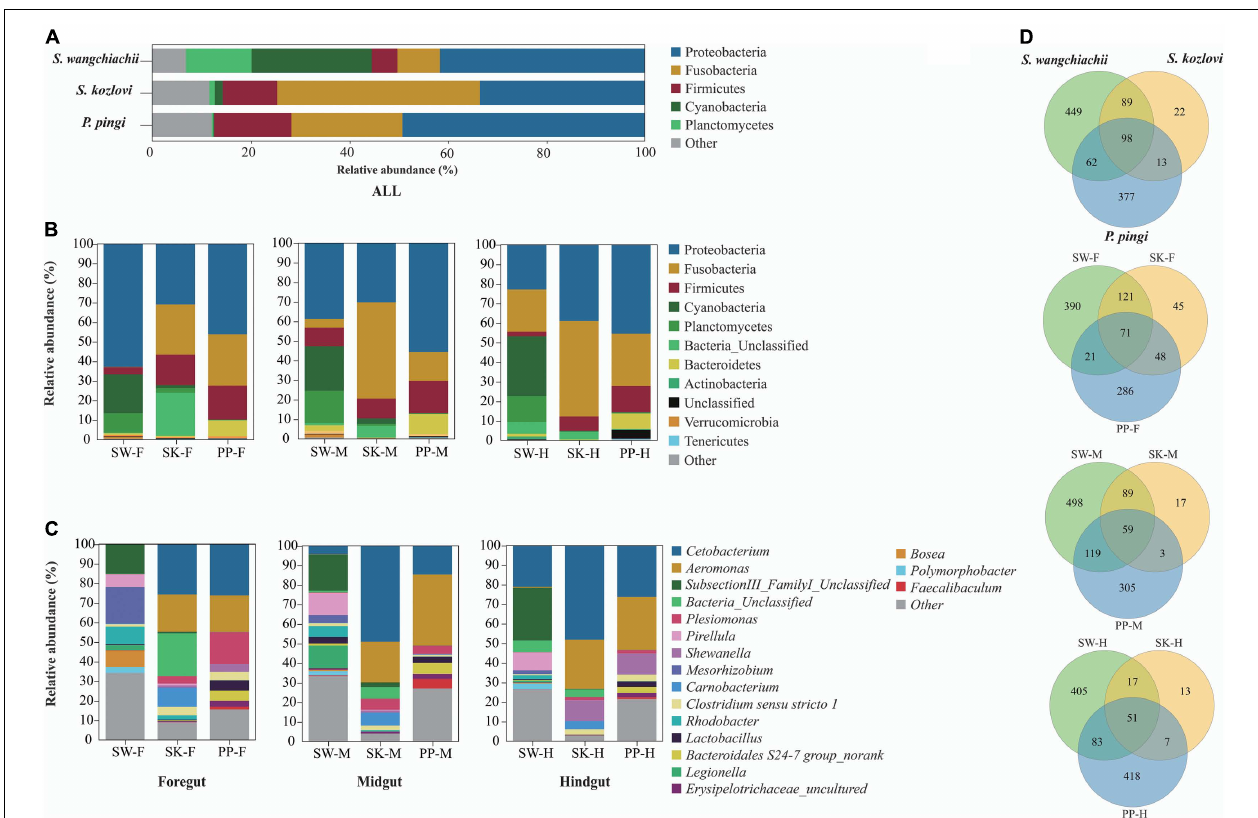
FIGURE 2 | Gut microbiome compositions of the three cold-water fishes. (A–C) The bar plot represents the gut microbiome composition of S. wangchiachii , S. kozlovi , and P. pingi among different intestinal sections at phylum and genus levels. (D) Venn diagrams based on the OTU level to analyze the differences of gut microbes of SW, SK, and PP. SW, S. wangchiachii ; SK, S. kozlovi ; PP, P. pingi ; F, foregut; M, midgut; H, hindgut.